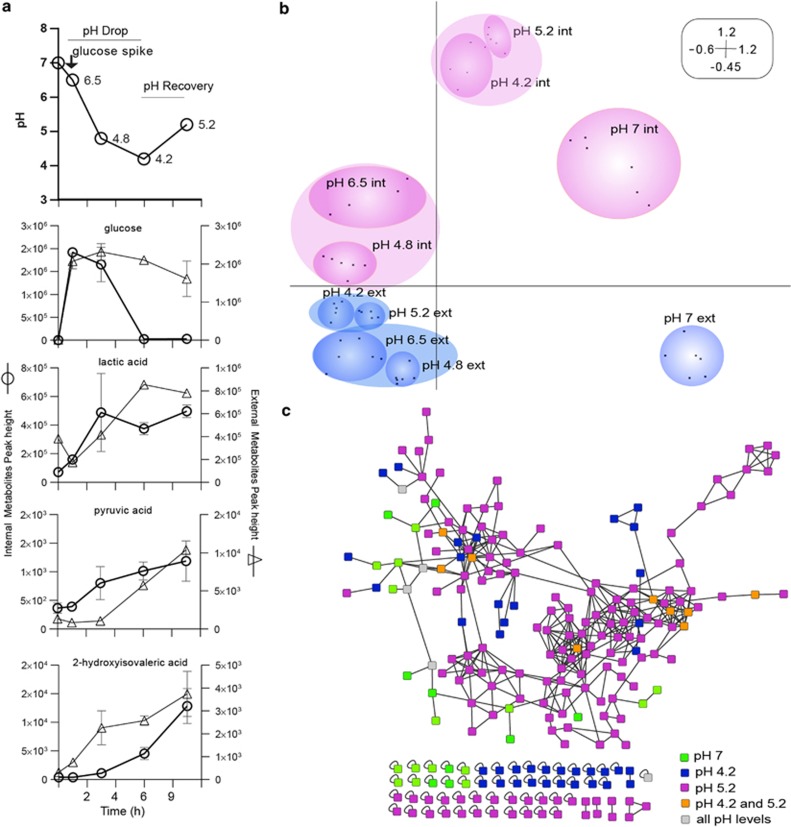
Primary metabolite and small molecule fingerprints are discernable temporally and cluster by environment. (a) Dynamic changes of extracellular pH and 133 metabolites with annotations in reference libraries. Metabolite measurements derive from both extracellular (open triangles) and intracelular (open circles) fractions before and after a glucose pulse. (b) Similarities between metabolite profiles obtained by gas chromatography-mass spectrometry (GCMS) from the extracellular (ext) and intracellular (int) biofilm environments at the different pH stages were analyzed with correspondence analyses (CA). The first ordination axis explains 53% of the variation of the data set and the second ordination axis explains 32% of the variation. Six replicate samples (depicted as small black squares in ordination diagram) from GCMS analyses were included to represent each environment and pH stage. (c) Tandem mass spectrometry (MS/MS) network of secreted mall molecules from biofilms at pH stages 7, 4.2 and 5.2. Molecular networks were obtained by spectral alignment as described in Watrous et al. (2012). Molecules with no structural homologues were included as singletons in the lower section of the network. The network comparison is based upon the similarity cosine scoring of MS/MS spectra and the visualization of those relationships. A single chemical species is represented as a colored node and the relatedness between spectra are represented as edges.